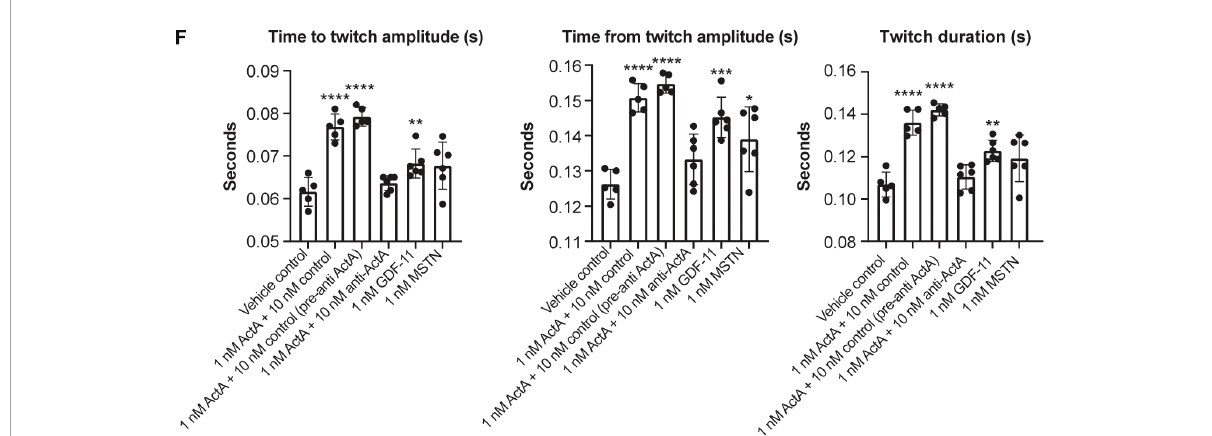
FIGURE7 Effect of Activin A on contractile function and arrhythmia in HECTs. (A) Effect of Activin A on cardiac rhythm in HECTs for spontaneous beat rate (beating in the absence of pacing) during the full treatment period and at 8 days post treatment. (B) Effect of Activin A, MSTN (GDF8), and GDF11 on cardiac rhythm in HECTs for spontaneous beat rate during treatment and at 8 days post treatment. (C,D) impact of Activin A and preventive Activin A inhibition on HECT contraction kinetics on day 20 and the reversal by applying anti–Activin A starting on day 20 to day 34. (E,F) Impact of Activin A, Activin A inhibition, MSTN (GDF8), and GDF11 on HECT contraction kinetics on day 20. Shading on D denotes the 95% confidence interval. One-way ANOVA was used to determine significance. * P < 0.05, ** P < 0.01, *** P < 0.001, **** P < 0.0001. ActA, Activin A; GDF, growth differentiation factor; HECT, human engineered cardiac tissue; MSTN,